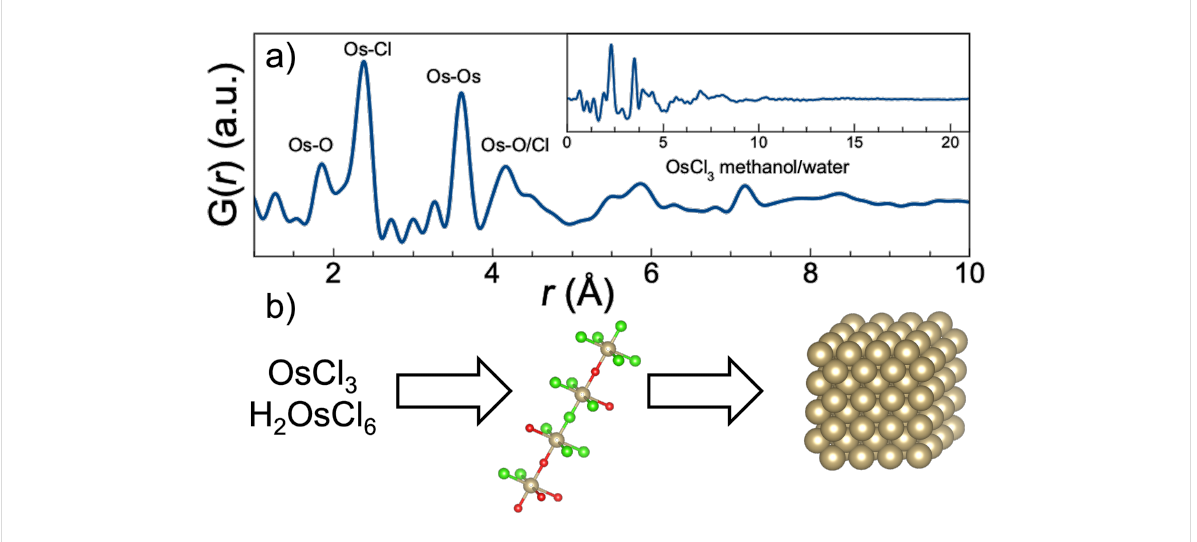
Figure 4: (a) Measured PDF of OsCl 3 in methanol/water. The insert shows the same PDF plotted to 21 Å. (b) Overall formation mechanism of the hcp Os NPs. The Os chloride precursor reacts with the alcohol/water mixture to form chain-like structures of [OsO x Cl y ]-octahedra, which after a long incu- bation time form Os NPs. Os, Cl, and O atoms are shown in grey, green, and red, respectively.